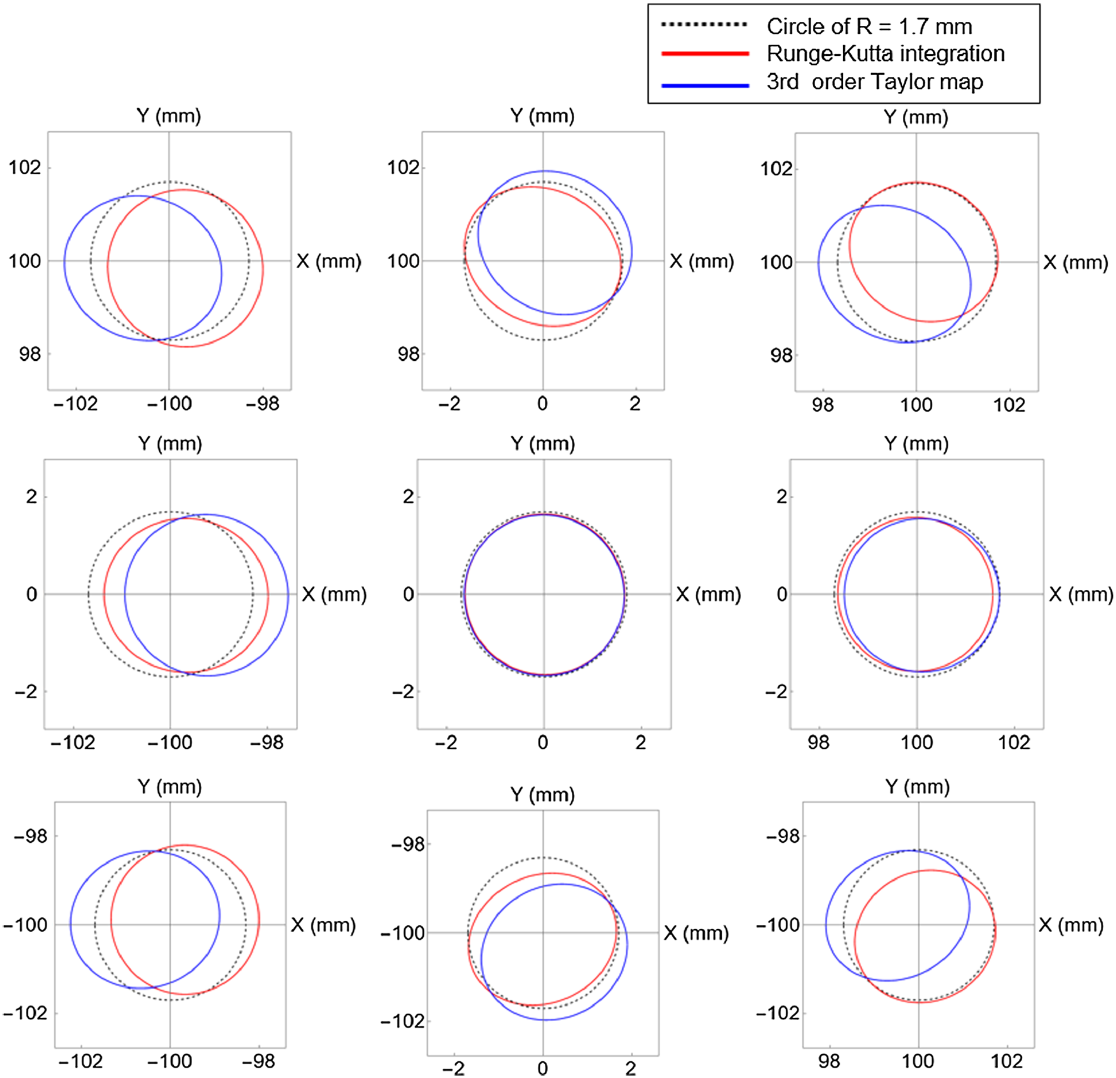
FIG. 11. 1 - σ beam ellipses of tracking results at the eight edges and the center of the scanning area. Red ellipses: Runge-Kutta integration; blue ellipses: third-order Taylor map. Each beam consists of 5000 particles. Black dashed circles with radius 1.7 mm are drawn as references.